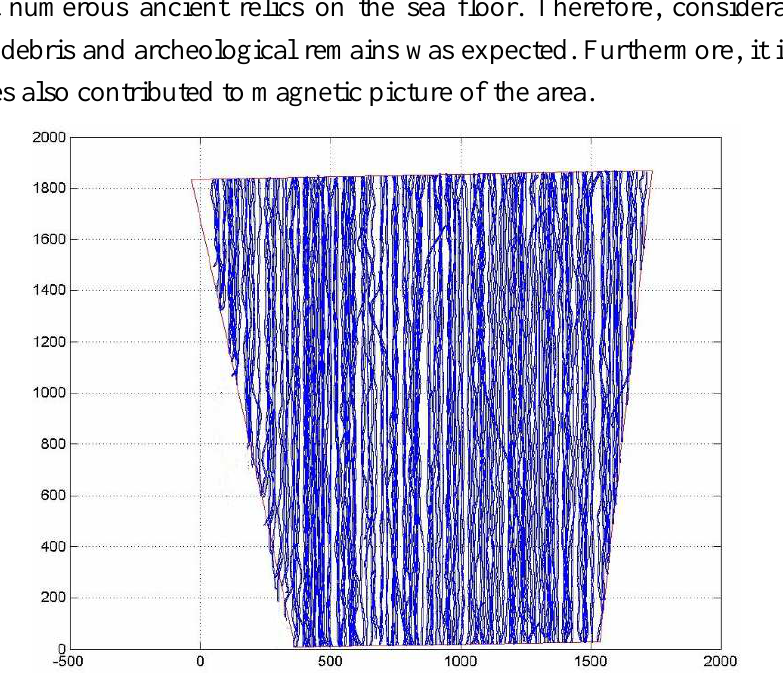
Figure 4. Survey area with the actual survey